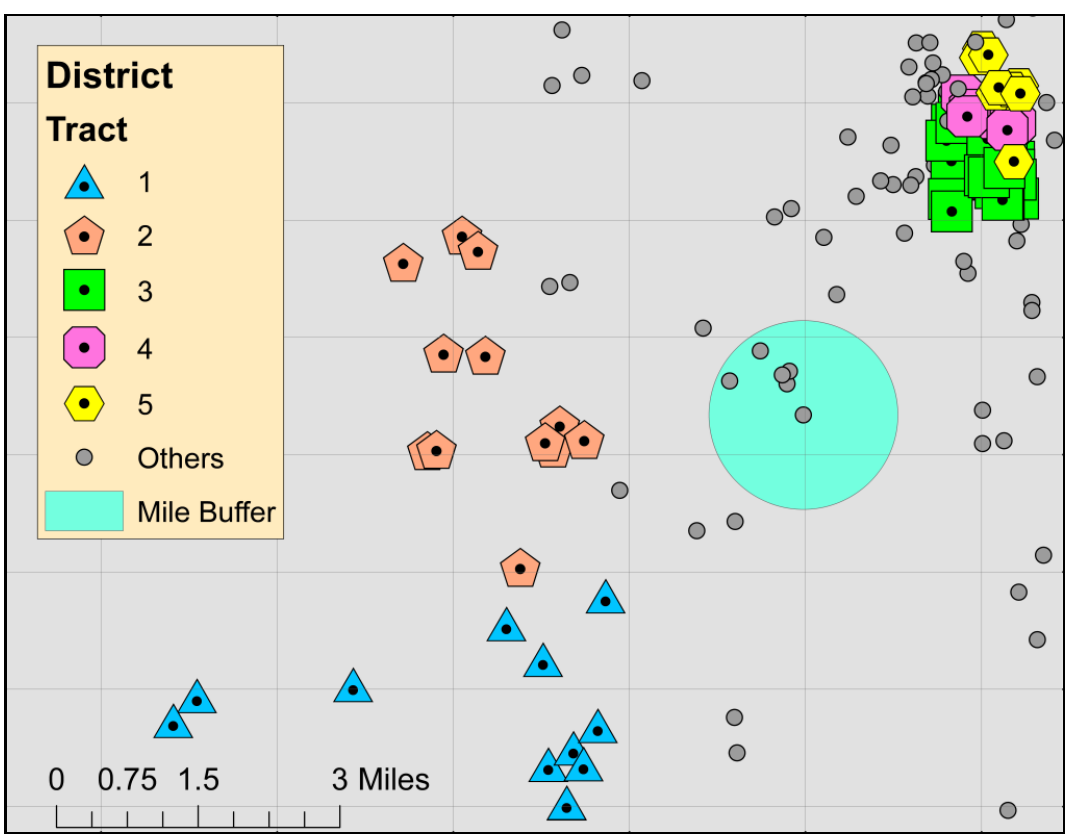
Figure 1: The spatial dispersion of individuals within a common school district and their association with different census tracts within that common environment. Spatial data were jittered/dispersed randomly to obscure the relative location of individuals, and only a subset of the total is shown. The five tracts pictured have the most affiliated respondents in this given school district; others are shown as gray dots. The one-mile buffer node was chosen randomly for illustration and has no real-world significance (i.e., it does not signify the school or other municipal